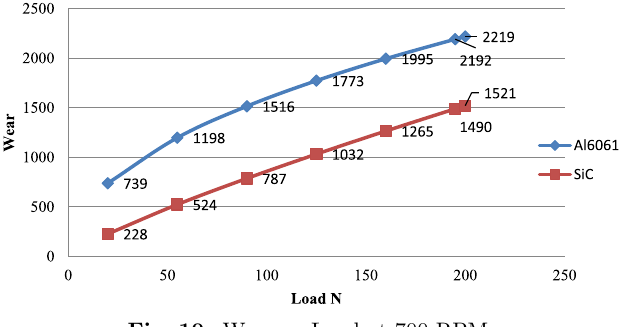
Fig. 10. Wear vs Load at 700 RPM.